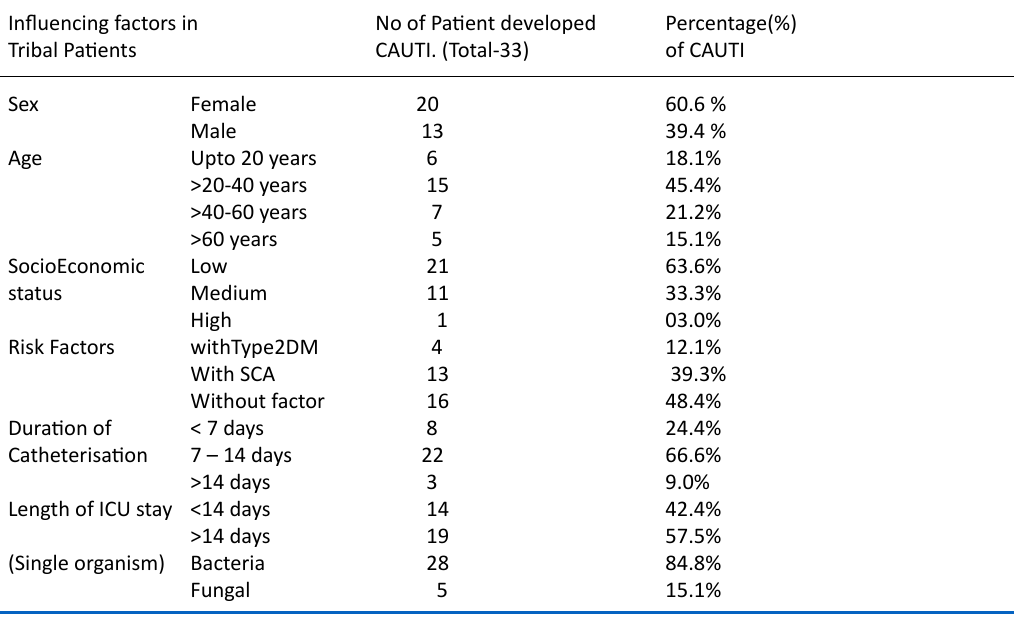
Table 2. Percentage of CAUTI associated with different Influencing factors in Tribal Patients Influencing factors in No of Patient developed Tribal